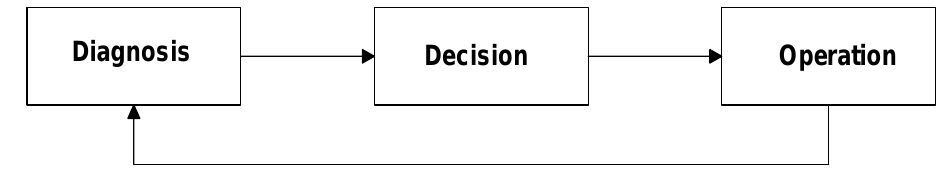
Figure 3. Operator’s accident management process.